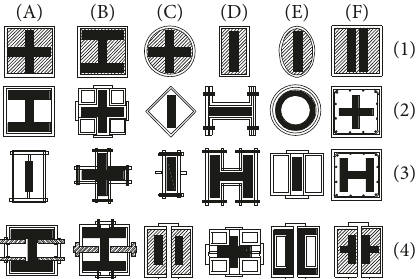
Figure 1: BRB sections proposed by several researchers